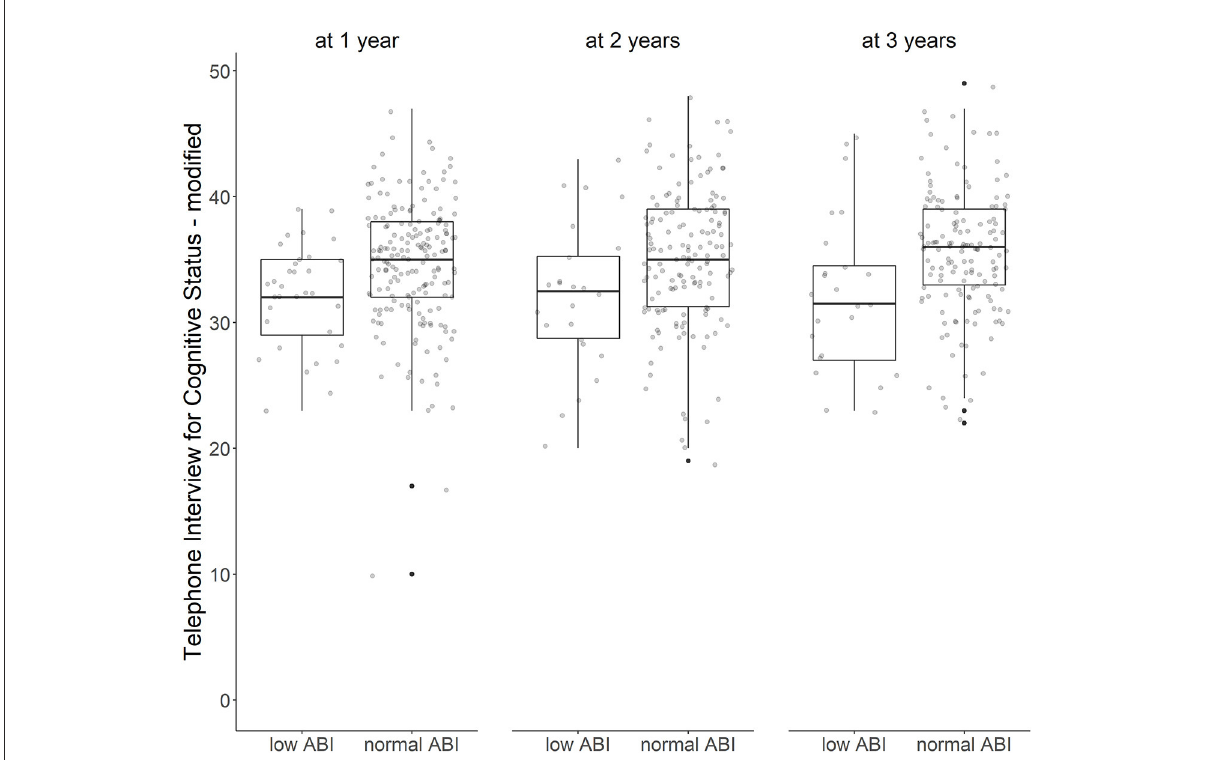
FIGURE1 ABI and cognitive function over time. Cognitive function after first ischemic stroke with low vs. normal ankle-brachial index at 1, 2, and 3 years after stroke (Tukey’s boxplots with jitter/scatterplot).